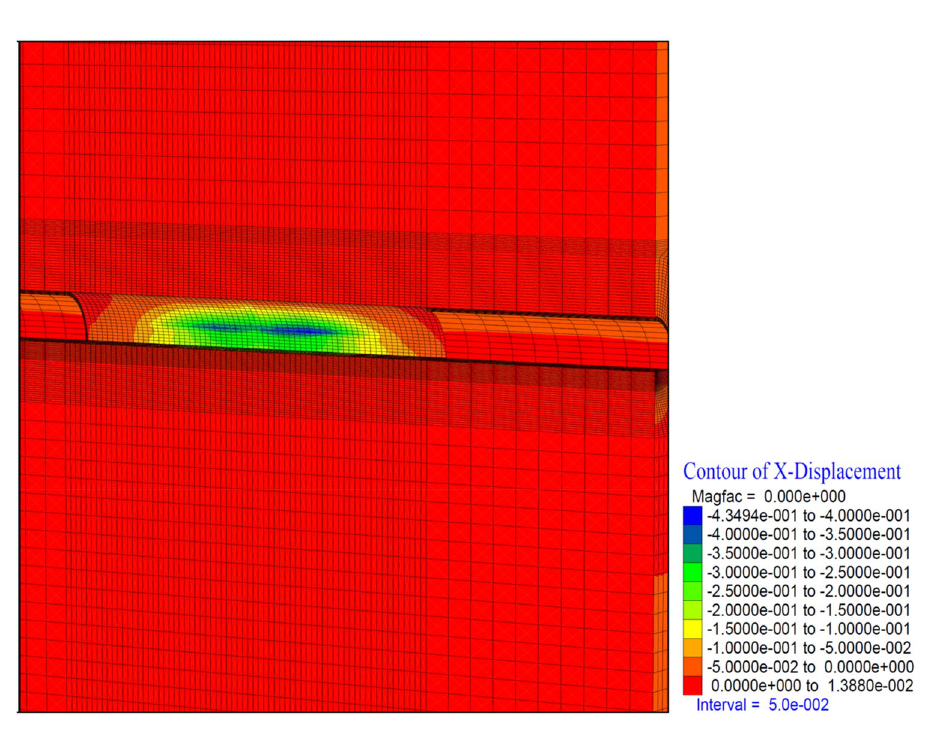
Figure 30. X displacement in stage